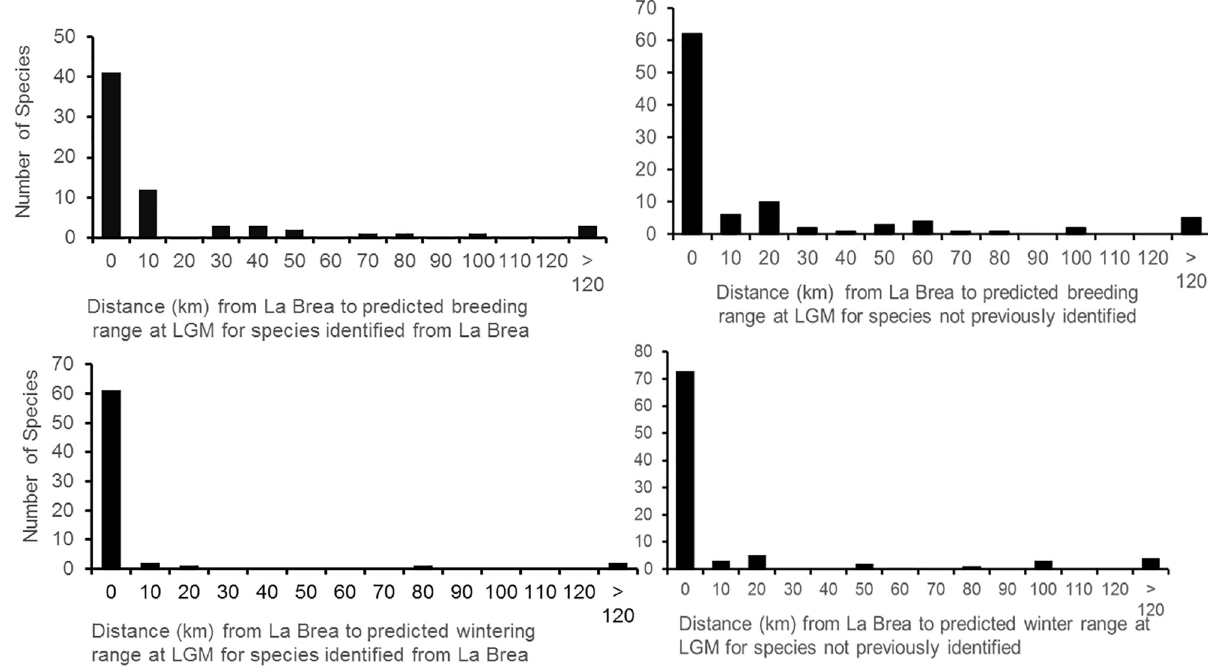
Fig 1. Distances from predicted distributions for birds documented or predicted to be breeding at La